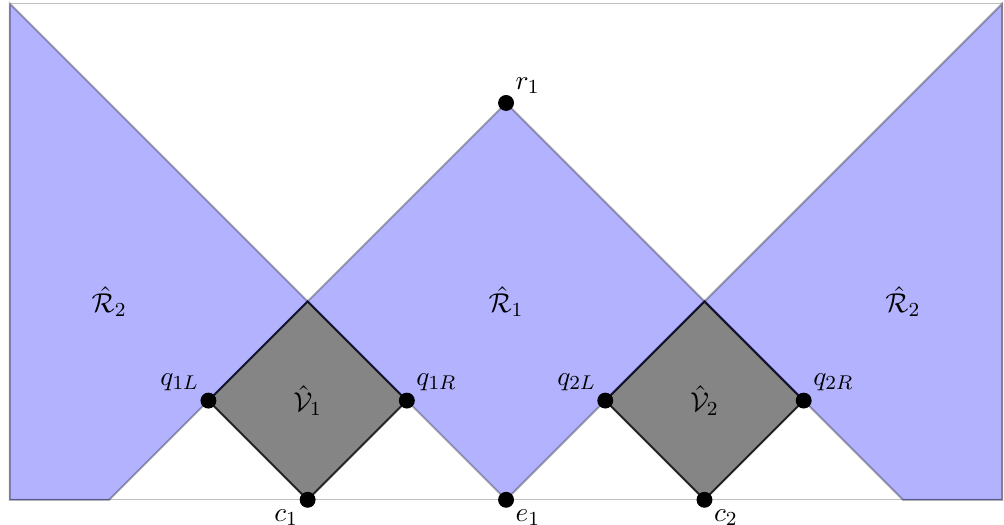
ˆ ˆ ˆ ˆ ˆ ˆ C 1 = V 1 , C 2 = V 2 , R 1 , R 2 in the boundary of Poincaré- 1 , c 2 , r 1 , e 1